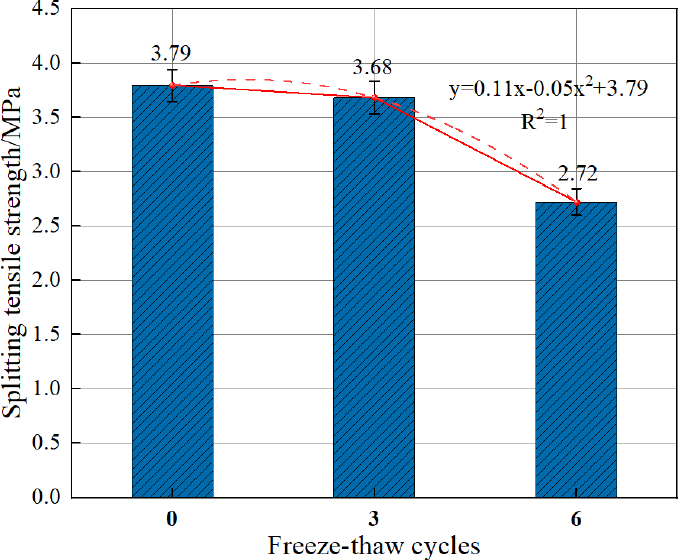
Figure 17. Effect of the number of freeze–thaw cycles on the splitting tensile strength of BFRC.